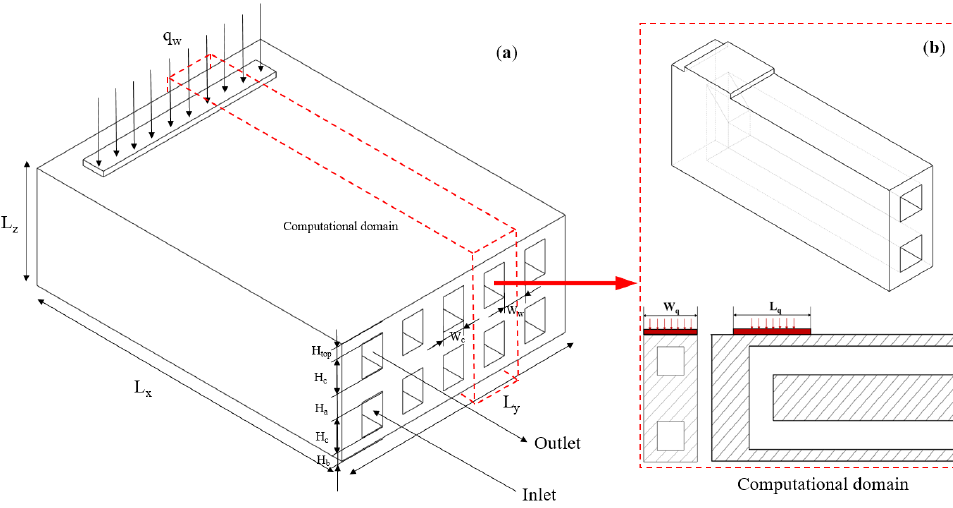
Figure 1. Schematic diagram of microchannel heat sink geometry ( a ) and computational domain ( b ). Table 1. Thermophysical properties of heat sink substrate materials and cooling fluid.